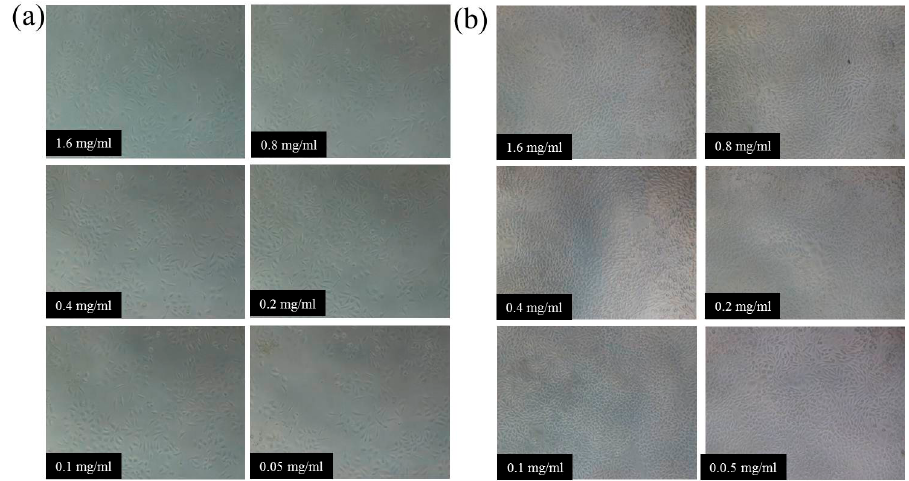
Figure 9. The micrographs of NIH3T3 cell distribution under the different concentrations of gel-3 samples: ( a ) cultivation for 24 h; ( b ) cultivation for 72 h.